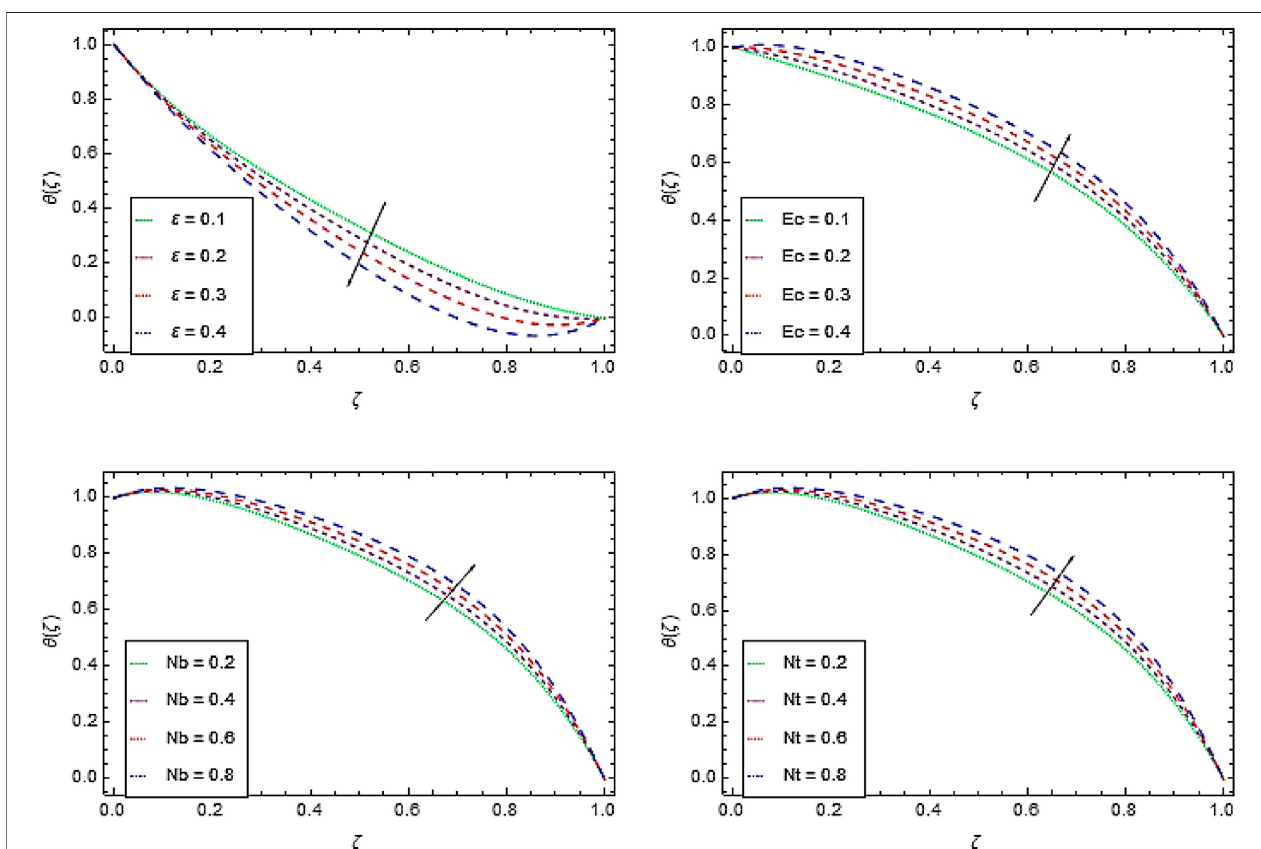
FIGURE 5 | θ ( ζ ) as a function of (A) ε , (B) Ec , (C) Nb , and (D) Nt